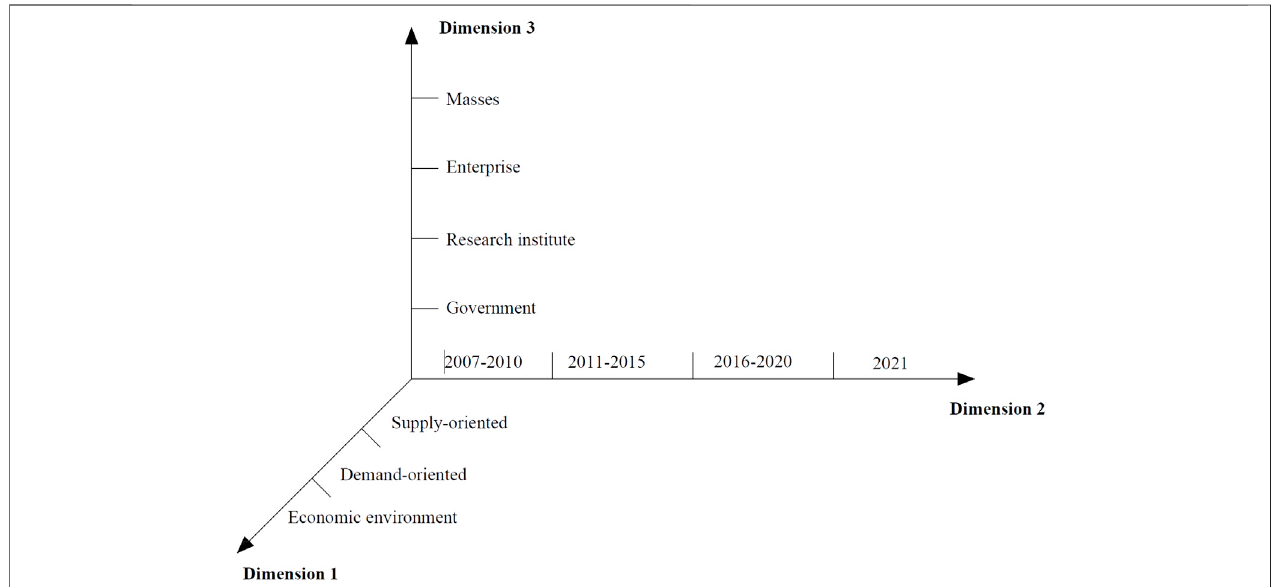
FIGURE 2 | Three-dimensional analysis framework of CR